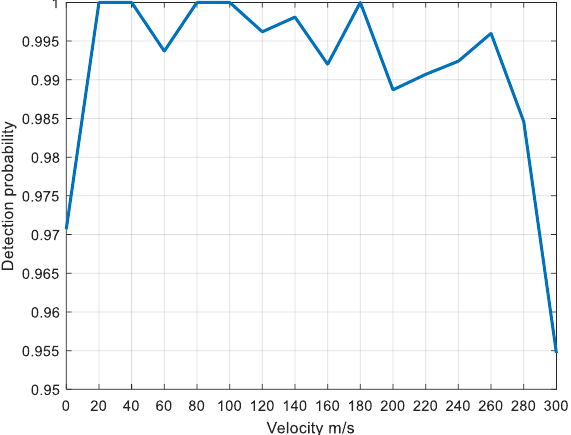
Figure 23. Detection probability diagram of scattering point under different SNR.